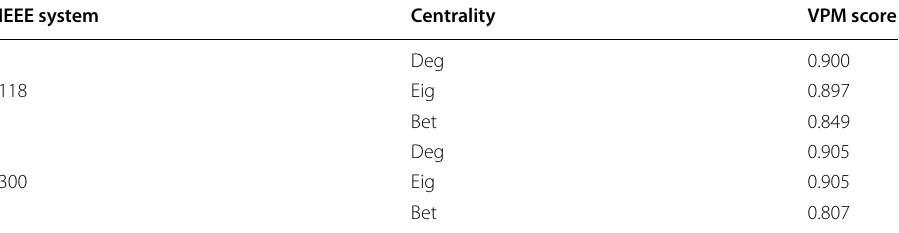
Table 4 Comparison of VPM scores using PTM centralities under IMCE malicious attack IEEE